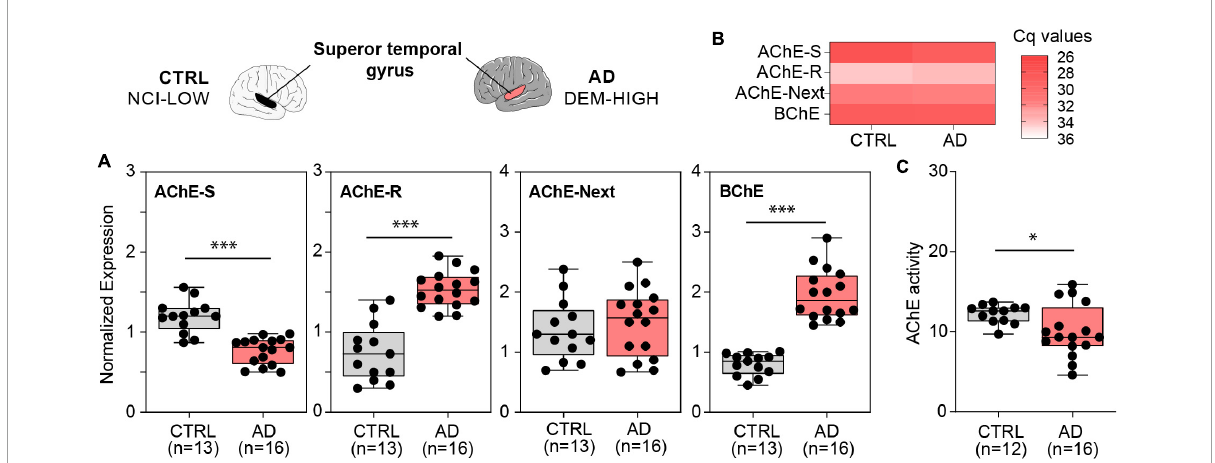
FIGURE3 ACHE and BCHE mRNA transcripts and AChE enzyme activity show changed levels in the superior temporal gyrus of AD patients vs. controls. (A) Lower AChE-S mRNA ( p < 4e-6), higher AChE-R mRNA ( p < 3e-6). Unchanged AChE-Next mRNA, and higher BChE mRNA ( p < 8e-9) in AD compared with controls, (B) qPCR-obtained Cq values for each cholinesterase show the predominance of the AChE-S splice variant over the AChE-R and AChE-Next transcripts in the superior temporal gyrus. (C) Decreased AChE enzyme activity ( p < 0.05) in AD compared to control brains. Normalized expression represents (cid:49)(cid:49) Cq, and enzyme activity is shown in nmol ATCh/min/mg protein, ∗ p < 0.05 and ∗∗∗ p < 0.001.